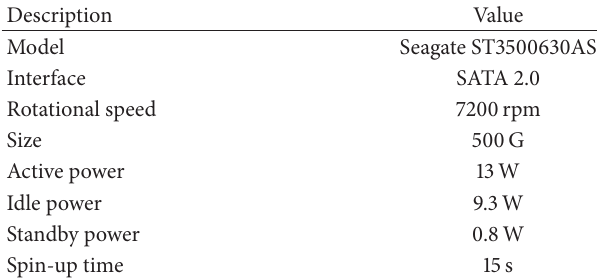
Table 3: The characteristics of the